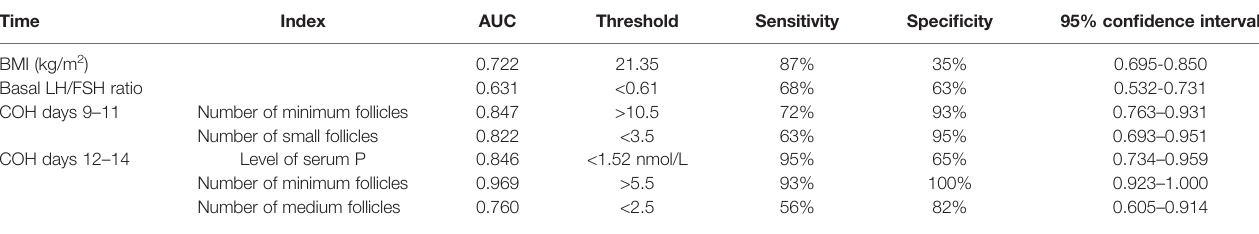
TABLE 2 | Results of single-factor indexes during the COH process in the ultra-long/long group